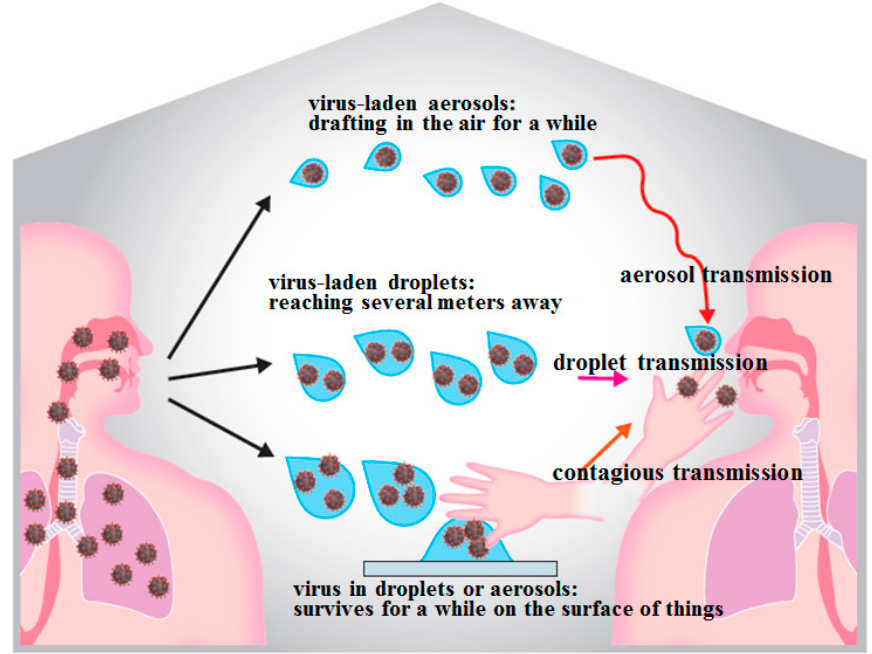
Figure 3. Mode of transmission of SARS-CoV-2 . To prevent SARS-CoV-2 infection, contact, droplet, and aerosol transmissions should be avoided. SARS-CoV-2 can be transmitted from asymptomatic subjects; therefore, it is important to wear masks, disinfect hands and fingers, ventilate the area, and avoid the “three Cs” (confined spaces, crowded places, and close-contact environments).